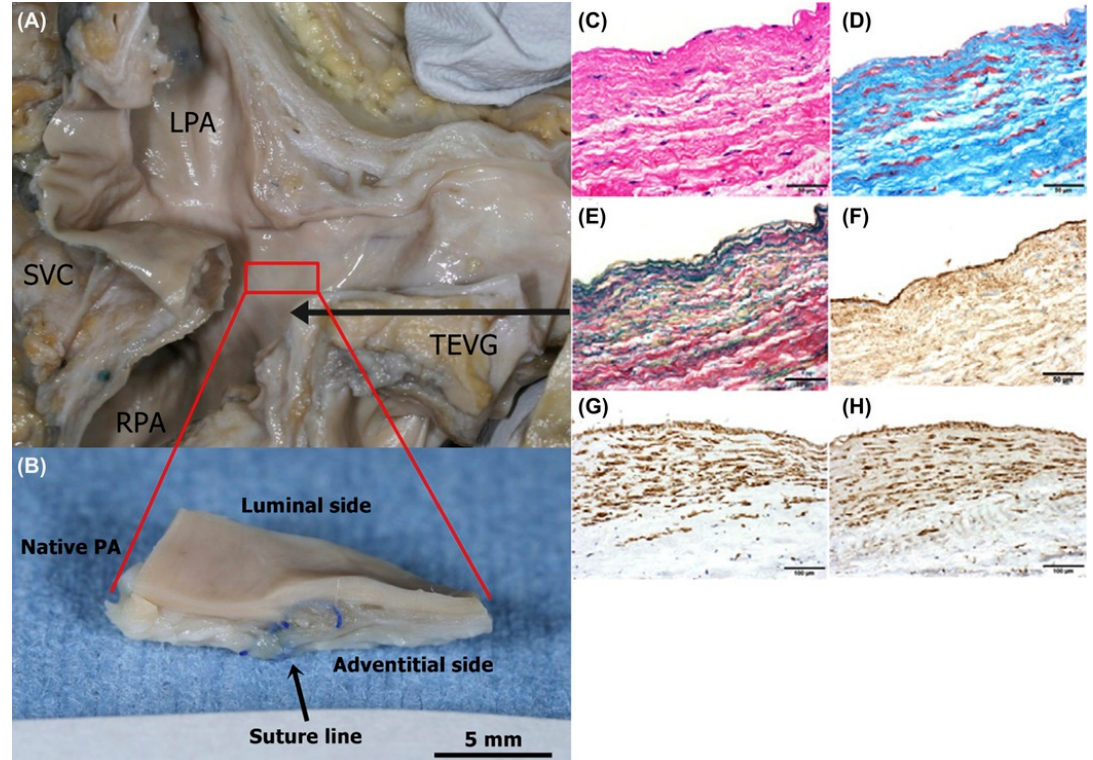
Figure 3. Postoperative and late-term TEVG angiography. ( A ) Postoperative angiography in patient 22. ( B ) Angiography 11 years after implantation in patient 22. ( C ) Postoperative angiography in patient 23. ( D ) Angiography eight years after implantation in patient 23. Arrows indicate the TEVG location. Angiography shows macroscopic growth of the TEVGs. Adopted with permission from Shinoka et al.